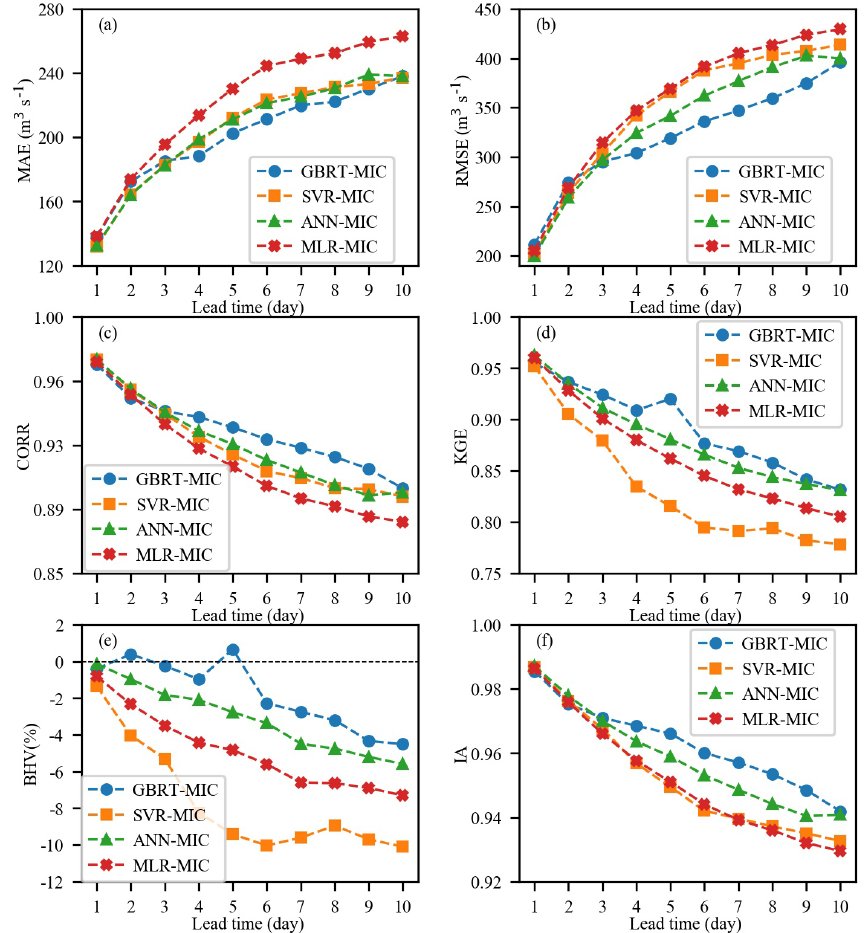
Figure 10. Performance of GBRT-MIC, SVR-MIC, ANN-MIC and MLR-MIC for the testing set (2017–2018) in term of the following six indices: (a) MAE, (b) RMSE, (c) CORR, (d) KGE, (e) BHV and (f)